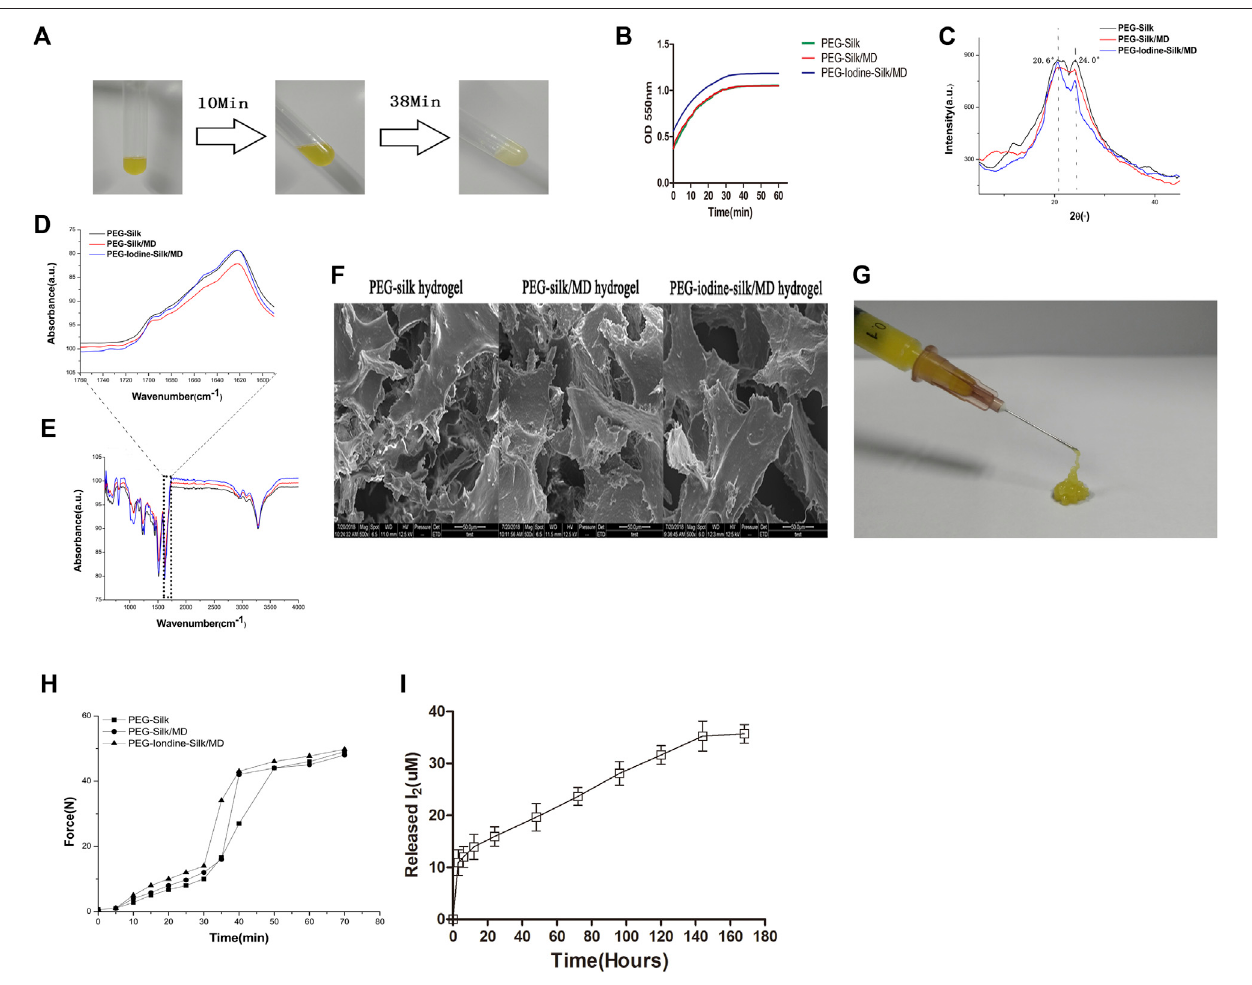
FIGURE 3 | Characterization of the silk hydrogels. (A) Gelation process after mixing silk fi broin, PEG 400, MD and PVP-I solution at room temperature. (B) Time- dependent OD measurement after mixing silk fi broin, PEG 400, MD and PVP-I solution. (C) XRD measurement of the silk hydrogels. (D,E) FTIR spectra of the PEG-silk hydrogel, PEG-silk/MD hydrogel and PEG-iodine-silk/MD hydrogel. (F) Silk hydrogel morphologies determined by SEM (scale bars = 50 µm). (G,H) Injectability measurement. (I)